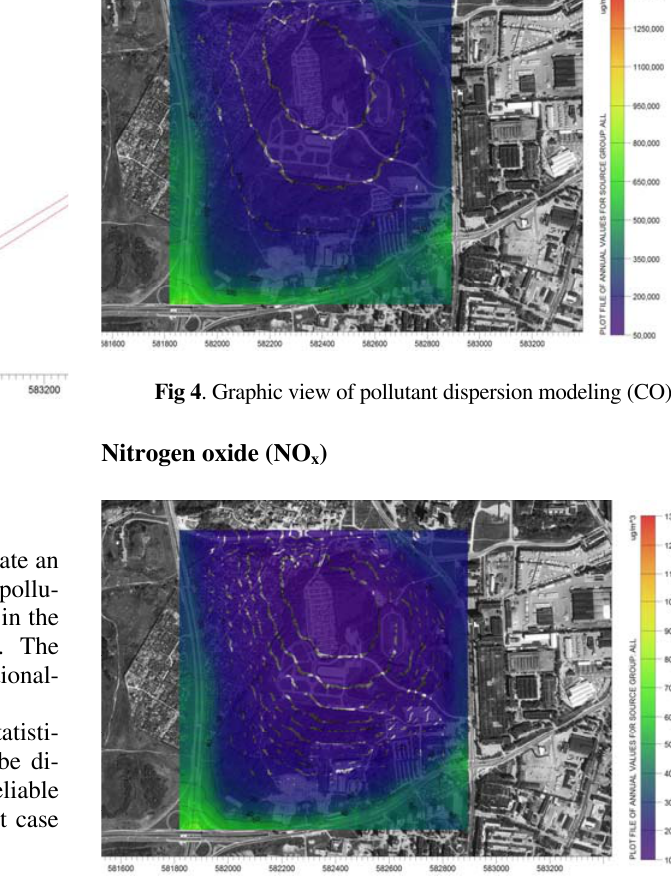
Fig 5 . Graphic view of pollutant dispersion modeling